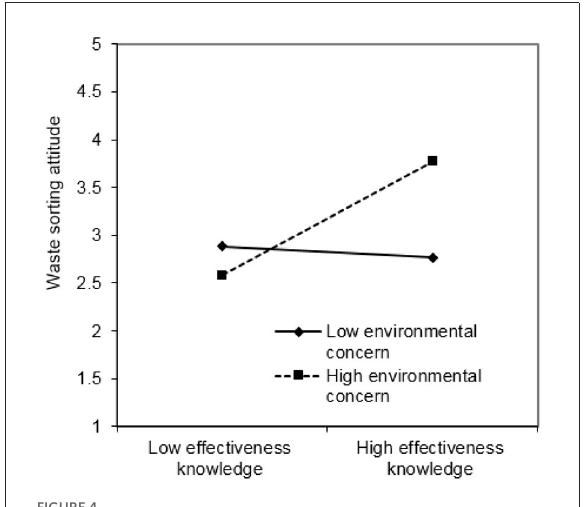
FIGURE4 Moderation plot of effectiveness